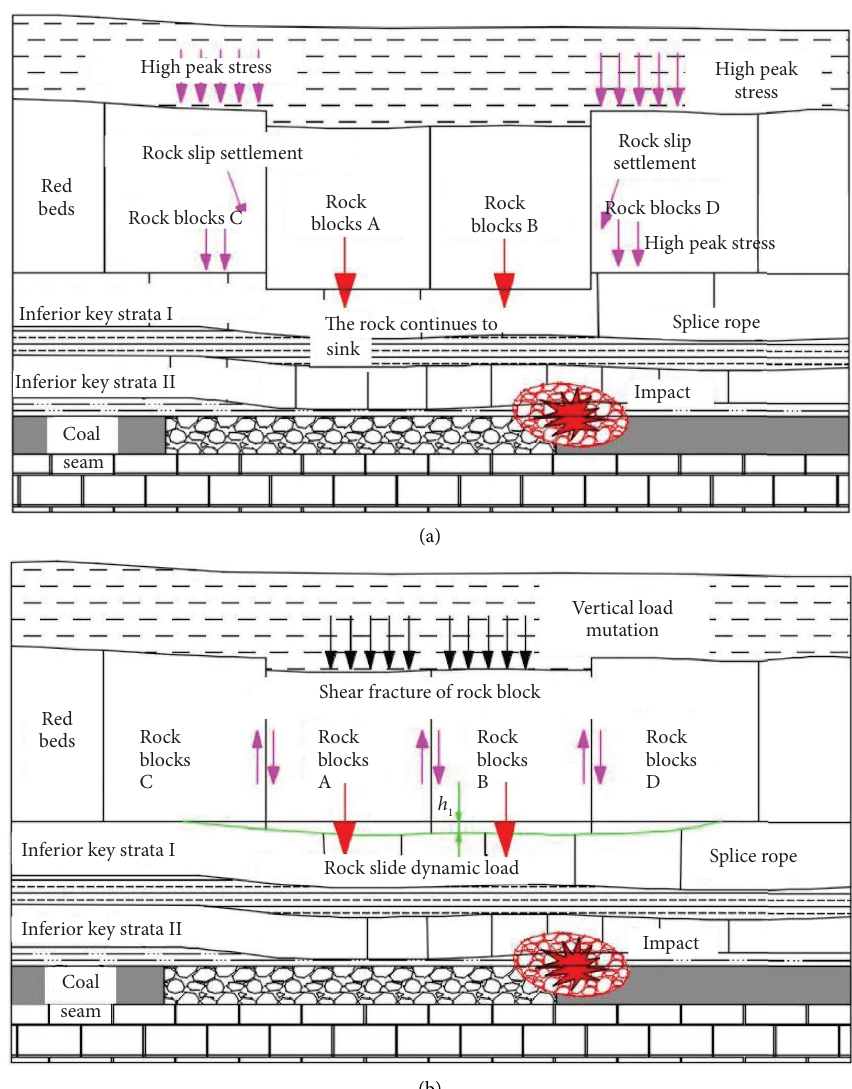
Figure 8: Rock burst-induced principle of hard rock coal mine earthquake. (a) Rock burst-induced principle of hard rock fracture. (b) Rock burst-induced principle of slip